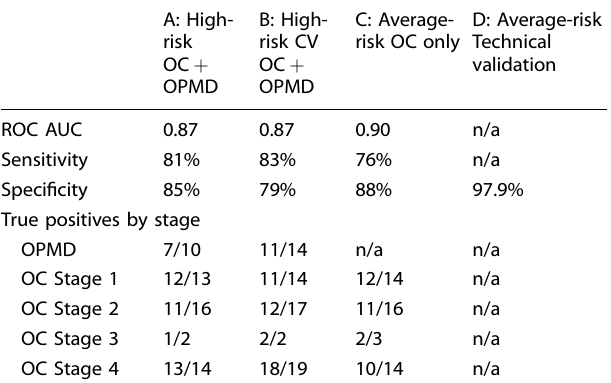
Table 2. Model performance for cohorts described in Table 1.